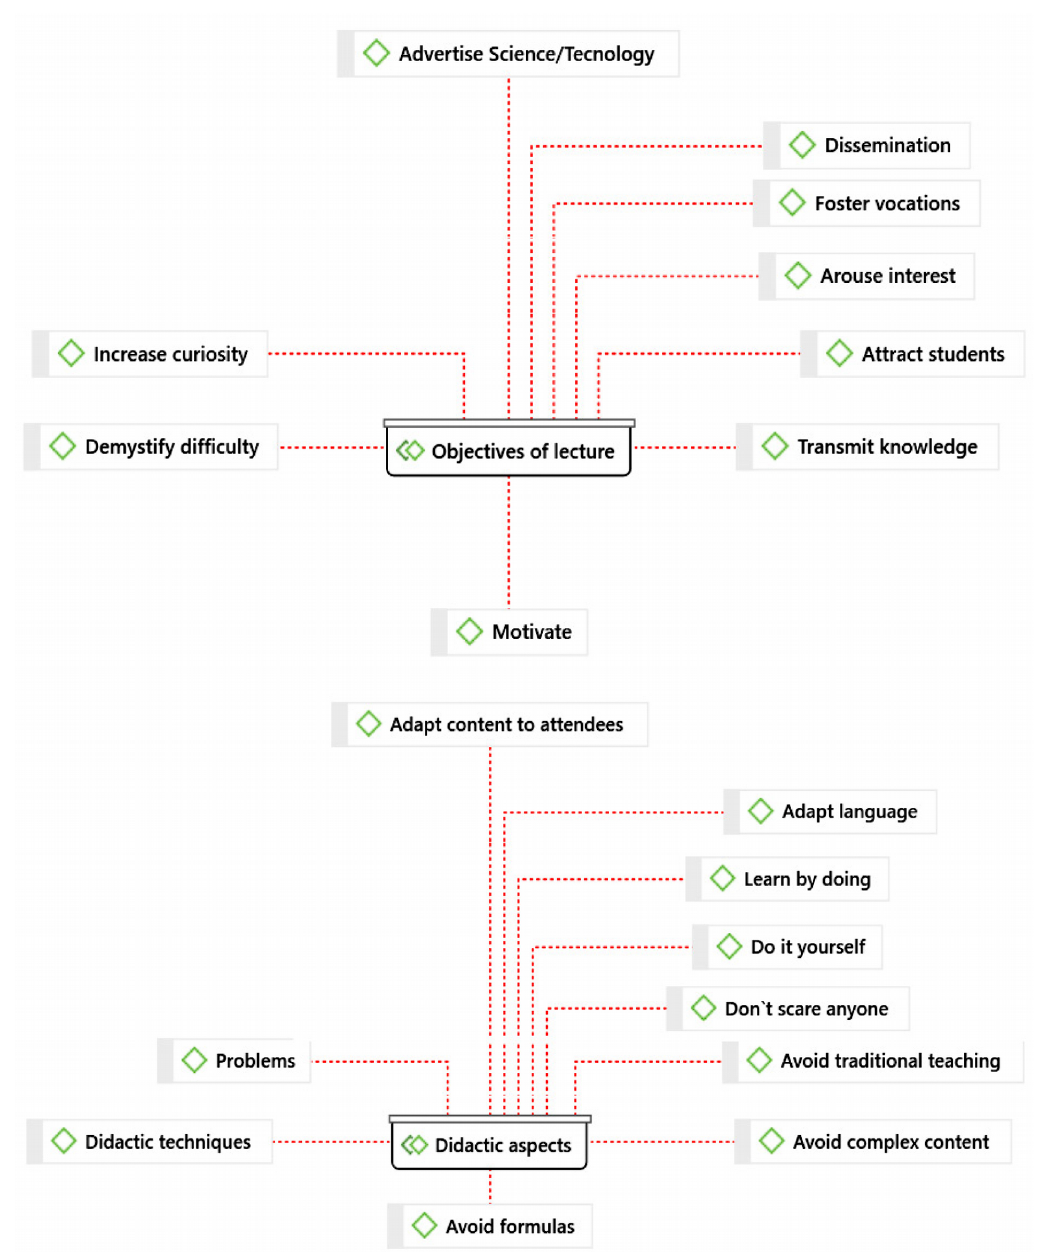
Figure 1. Networks of code groups of the Conference objectives and Didactic